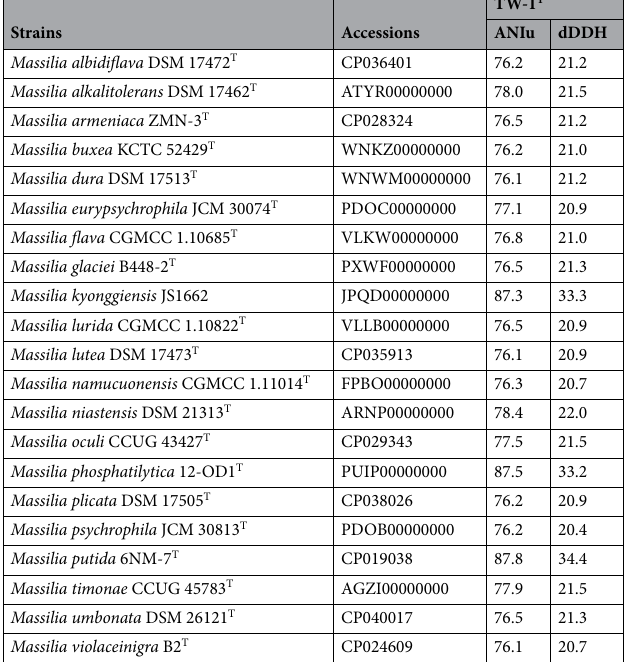
Table 1. Average nucleotide identity (ANIu) and digital DNA-DNA hybridization (dDDH) between strain TW-1 T and phylogenetically closest members of the genus Massilia .